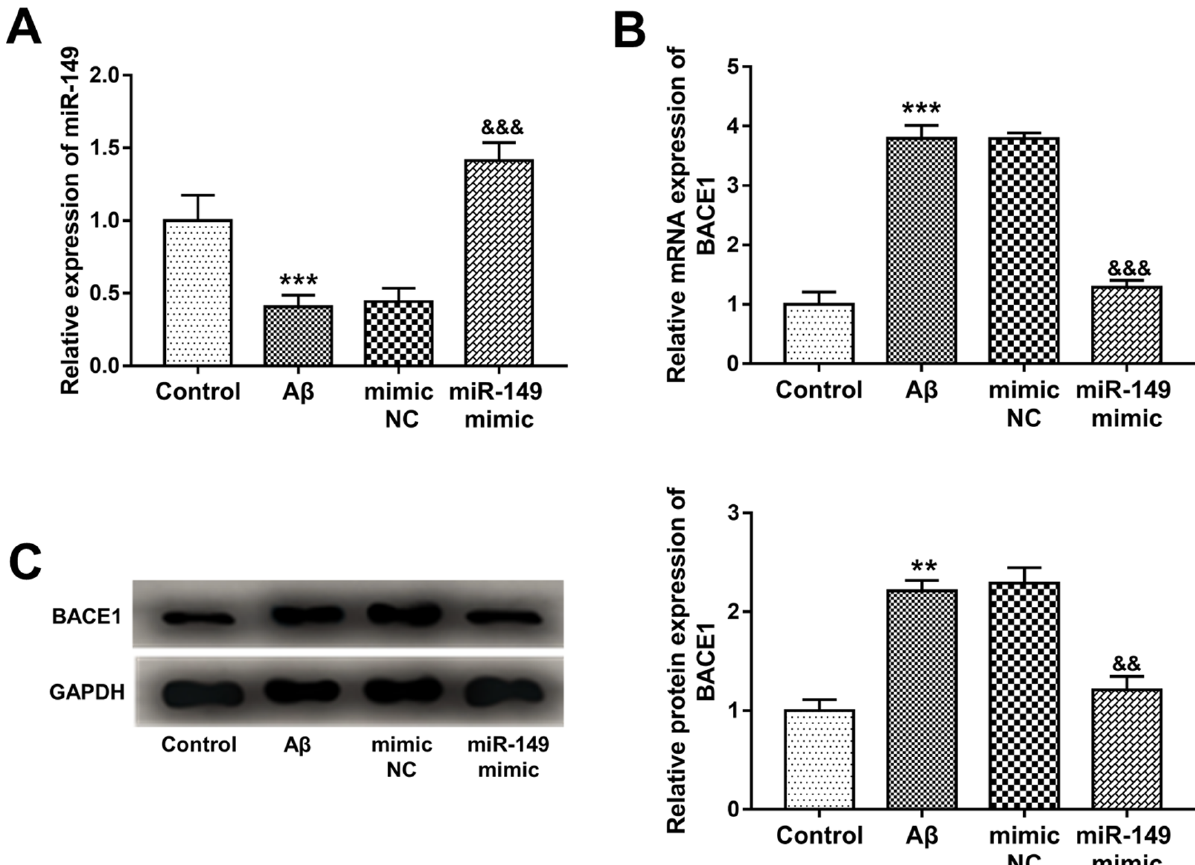
Figure 5 - Expression of miR-149 in Aβ-treated SH-SY5Y cells and its negative regulatory effect on BACE1 expression. A . Aβ treatment in SH-SY5Y led to inhibited miR-149 expression, but cell transfection with miR-149 mimic significantly promoted the expression miR-149. B . The increased mRNA expression of BACE1 in Aβ-treated cells was inhibited by the overexpression of miR-149. C . The protein expression of BACE1 in Aβ-treated cells with miR-149 overexpression. ** P < 0.01, *** P < 0.001 vs. Control; && P < 0.01, &&& P < 0.001 vs. Aβ.